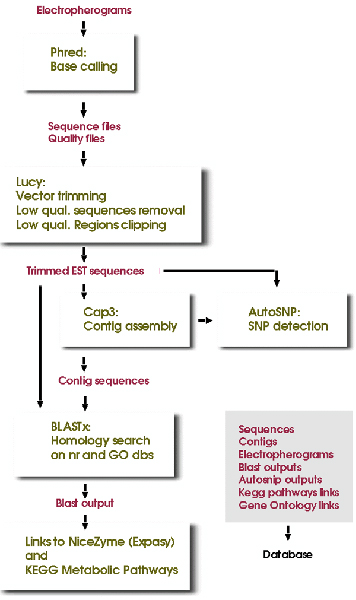
The ESTree db pipeline. Data flow in the ESTree db pipeline. Accessory in-house developed Perl programs are not shown in the scheme.